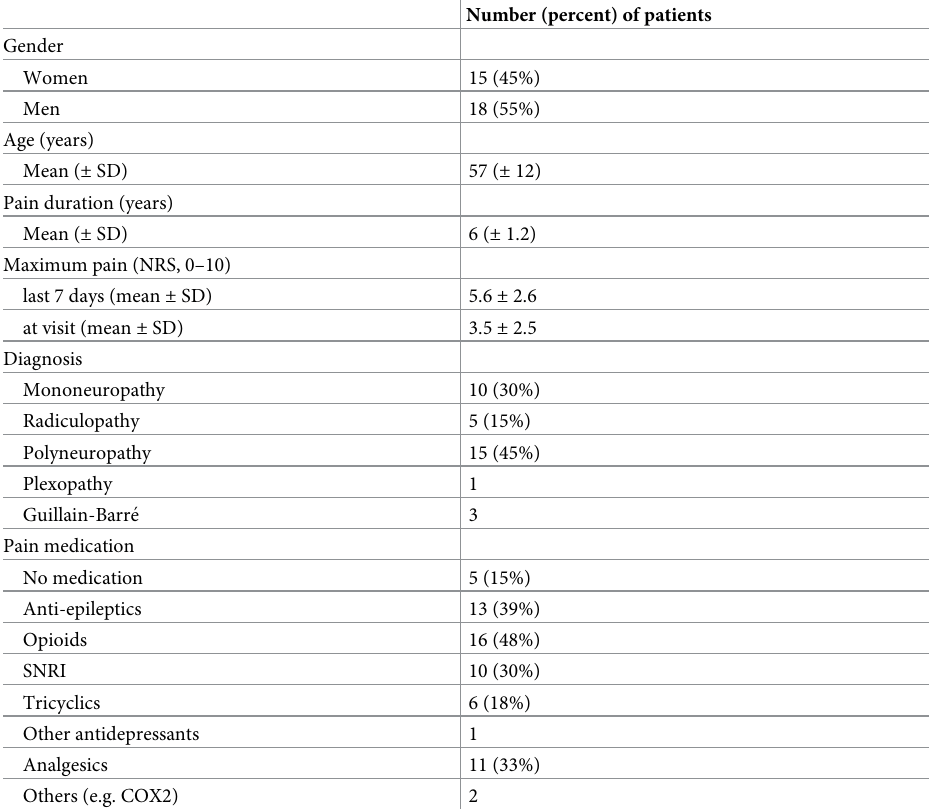
Table 1. Clinical characteristics of the